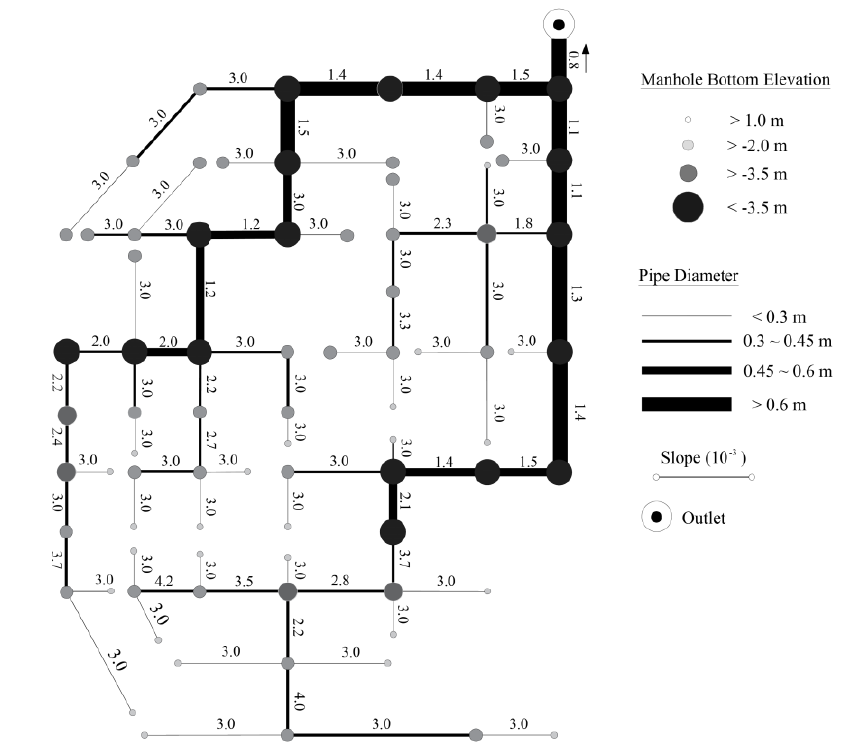
= 𝟔𝟖% and 𝐂𝐨𝐬𝐭 = 𝟐. 𝟏𝟖𝐞𝟔 ) <𝟗𝟎